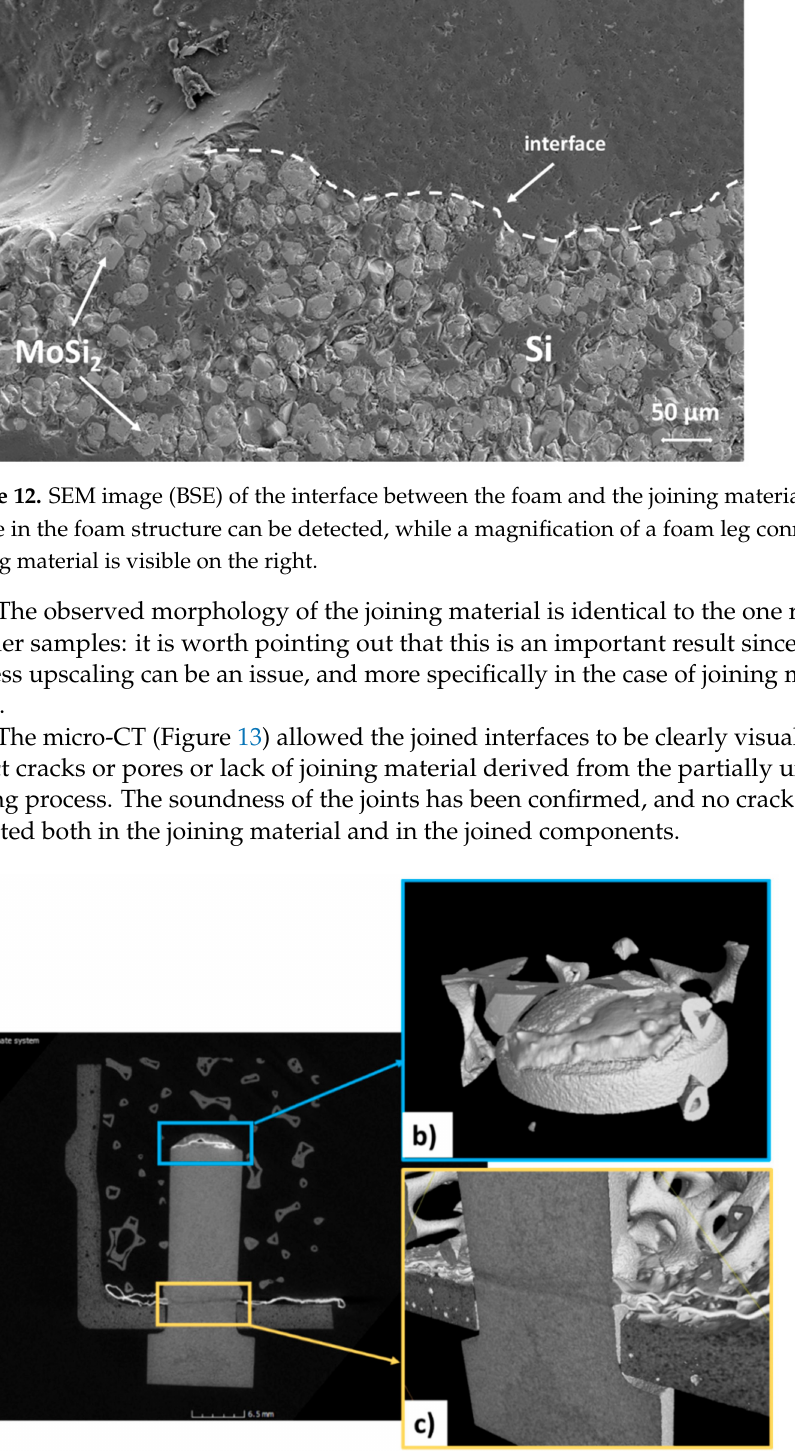
Figure 13. Tomographic reconstruction of the joined mock-up: cross-section ( a ) details of the joining material on the pinhead ( b ) and near the hole ( c